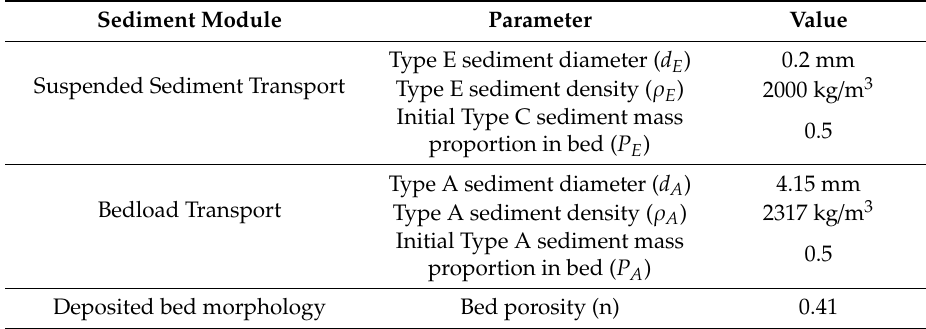
Table 3. Sediment module parameters used in SSF for erosion functionality analysis.